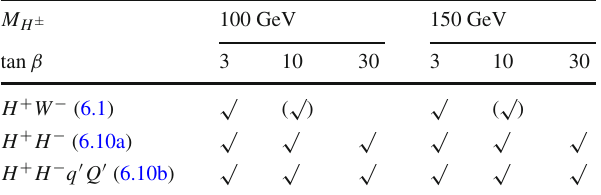
Table 4 Proposed channels, denoted by ing resonant production, at 30 fb − 1 . The cases denoted by ( need higher luminosity